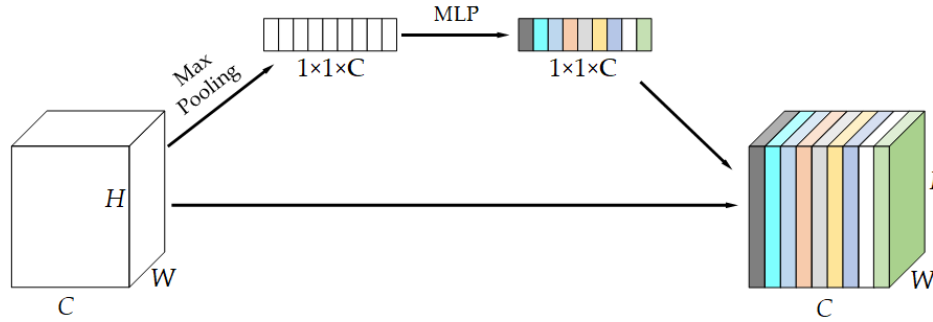
Figure 5. Structure of SEBlock module.